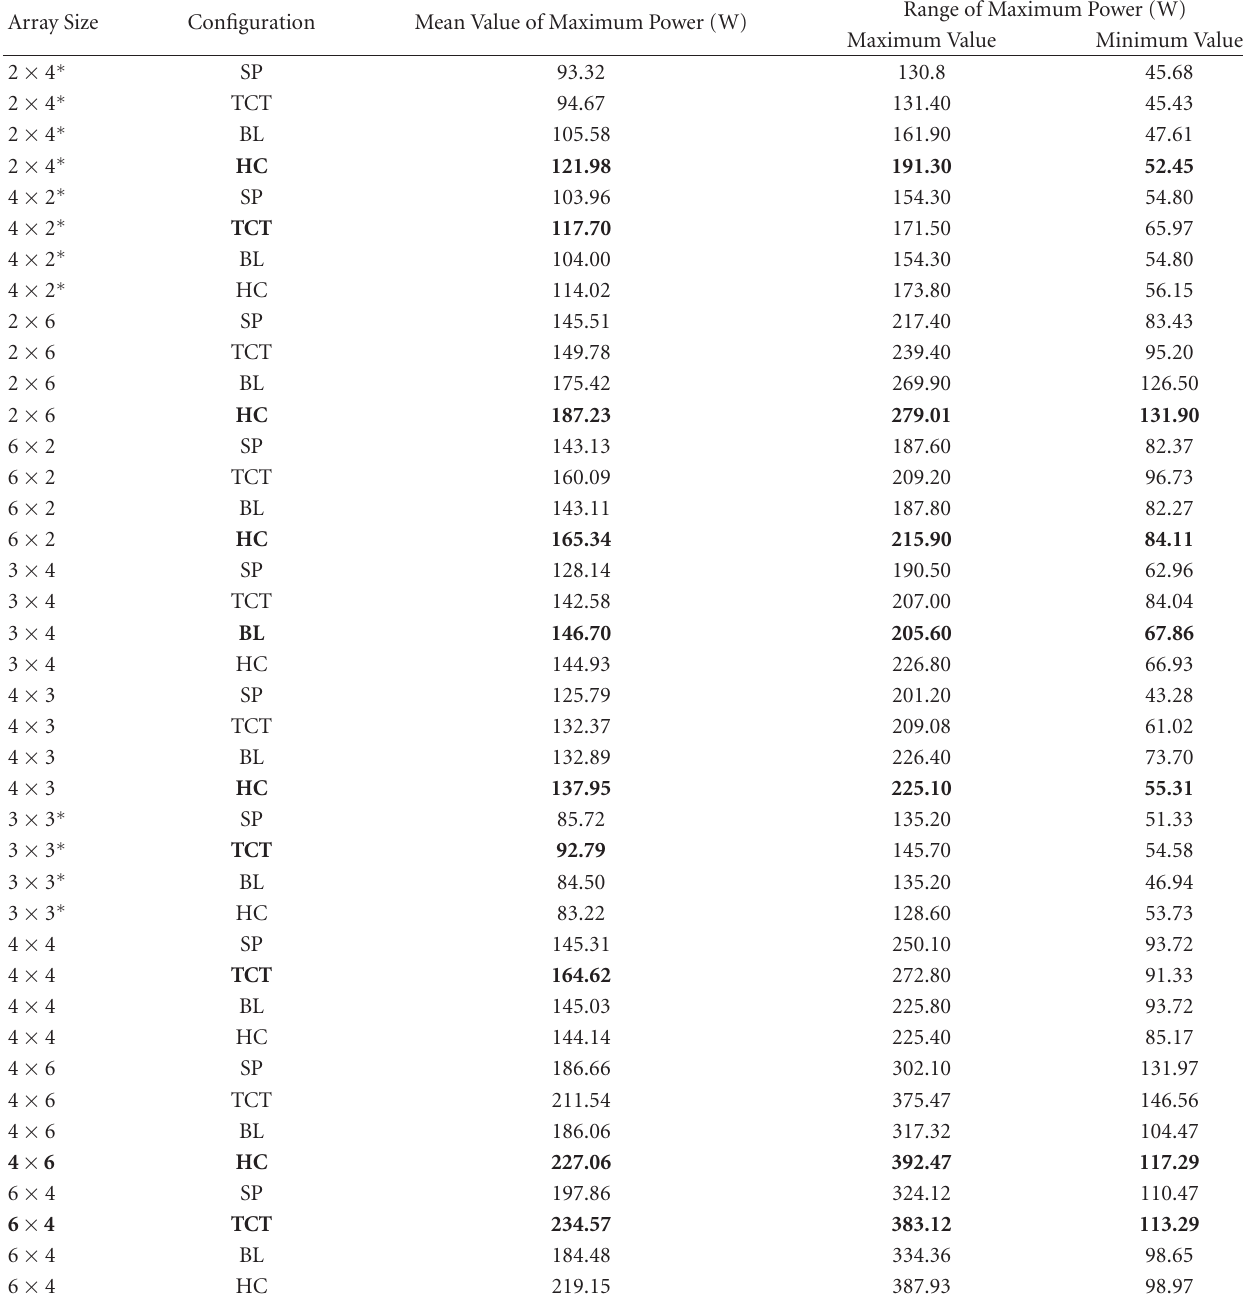
Table 4: Mean and Range of the maximum power for di ff erent configurations with di ff erent sizes under random shading patterns ( ∗ Readings practically verified vide Section